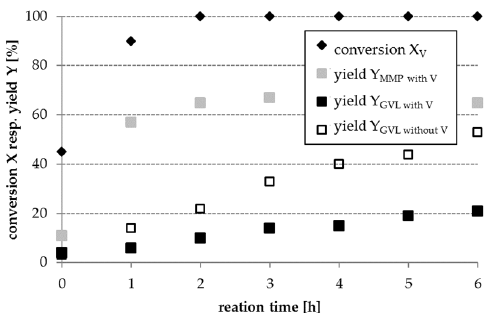
Figure 6. Conversion of V and yields of MMP and GVL as a function of reaction time during the hydrogenation of LA and V with FA resp. LA with FA (without V) in presence of a Pt / AC catalyst (x cat. = 0.24% w / w in reactant solution, T = 493 K, c LA = 22.06 g L − 1 , c FA = 27.16 g L − 1 , c V = 4.56 g L − 1 resp. c V = 0 g L − 1 , n = 700 min − 1 stirring speed and autogenous pressure).